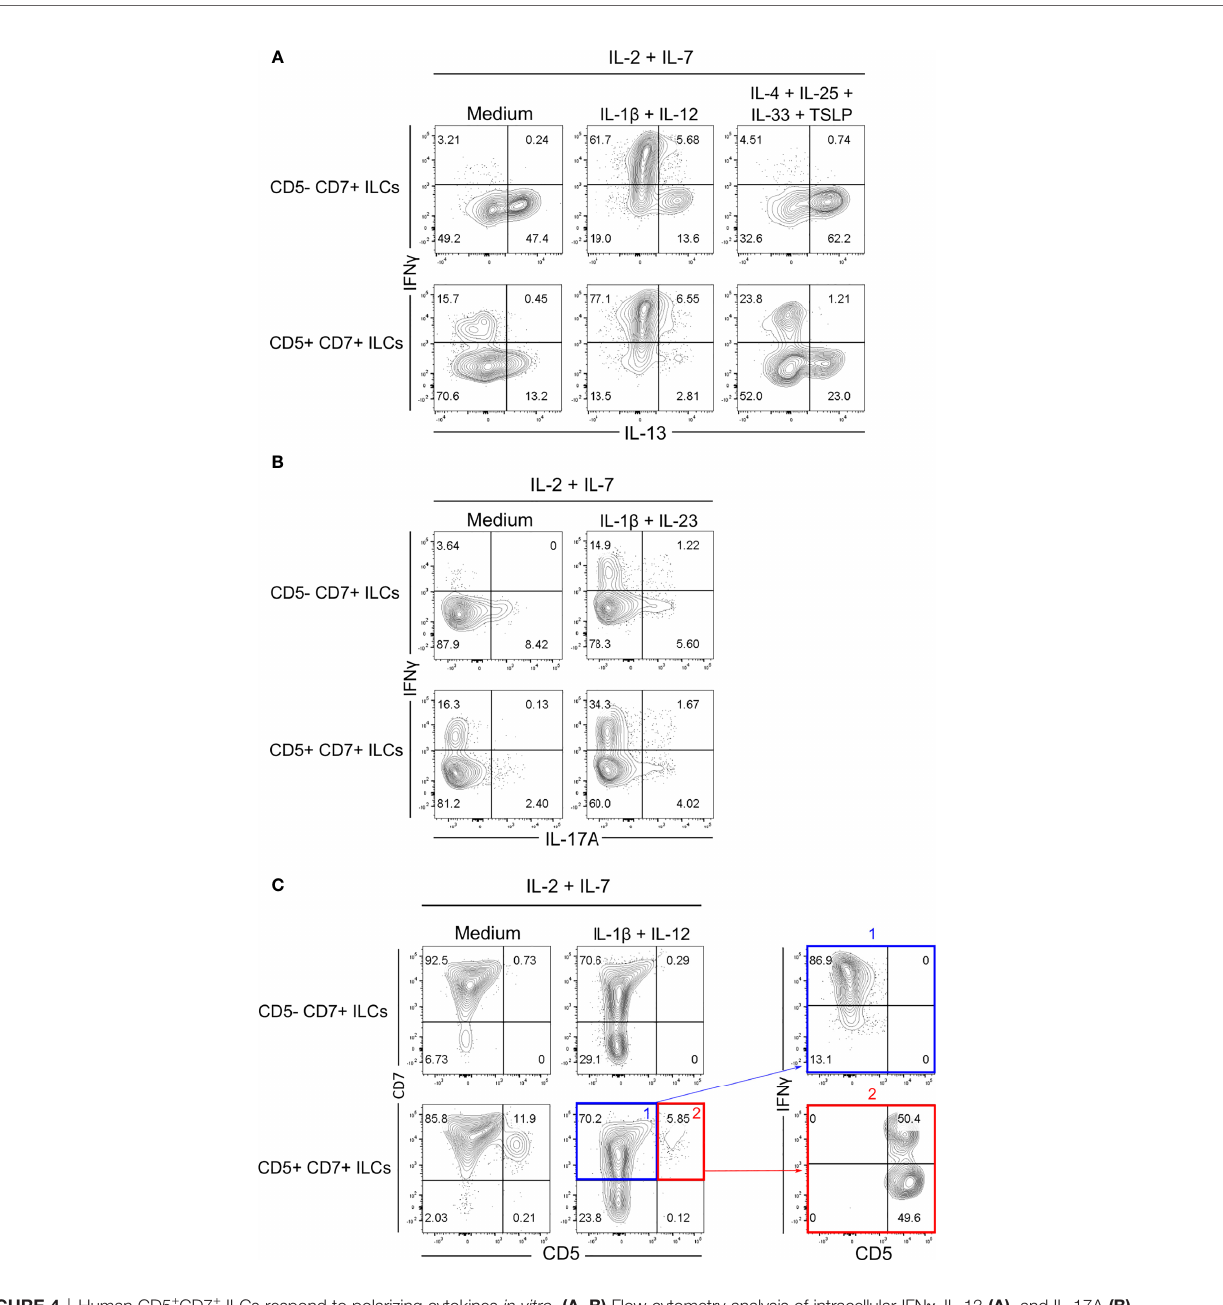
FIGURE 4 | Human CD5 + CD7 + ILCs respond to polarizing cytokines in vitro. (A, B) Flow cytometry analysis of intracellular IFN g , IL-13 (A) , and IL-17A (B) expression by CD5 - CD7 + ILCs (top row) and CD5 + CD7 + ILCs (bottom row) one week after co-culture with OP9-DL1 cells in the presence of the indicated polarizing cytokines. CD5 - CD7 + and CD5 + CD7 + ILCs were puri fi ed from human peripheral blood by cell sorting. Cells were gated as in Supplementary Figure 3A . Non- stimulated controls are shown in Supplementary Figure 3B . (C) Cell surface expression of CD5 and CD7 on puri fi ed CD5 - CD7 + ILCs (top row) and CD5 + CD7 + ILCs (bottom row) one week after co-culture with OP9-DL1 cells and IL-2+IL-7 only or with OP9-DL1 cells and IL-2+IL-7+IL1 b +IL-12. Dot plots on the right show IFN g production by CD5 + CD7 + ILCs that have down-modulated (blue) or maintained (red) CD5 surface expression. Data are representative of at least two independent